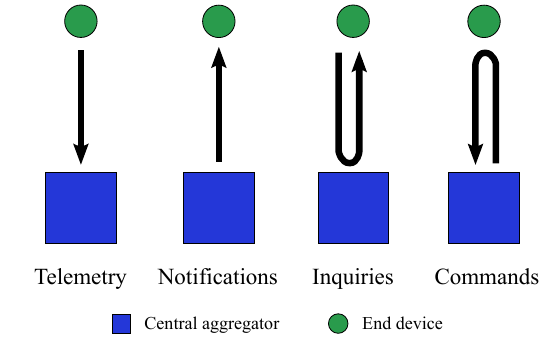
Figure 2. Communication